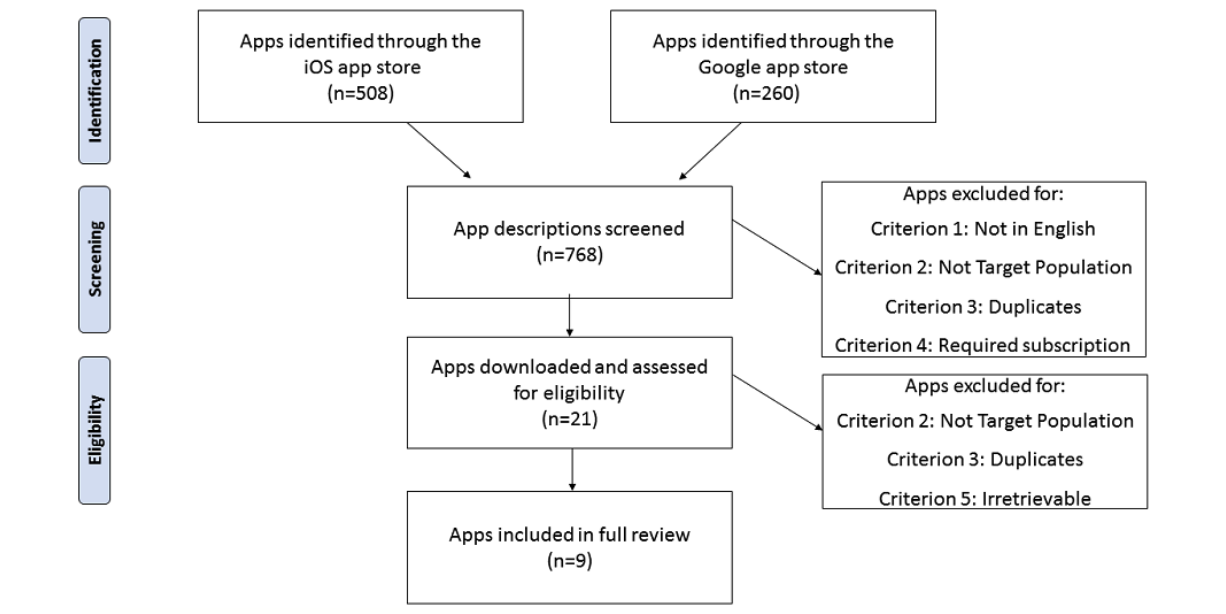
Figure 2. App inclusion